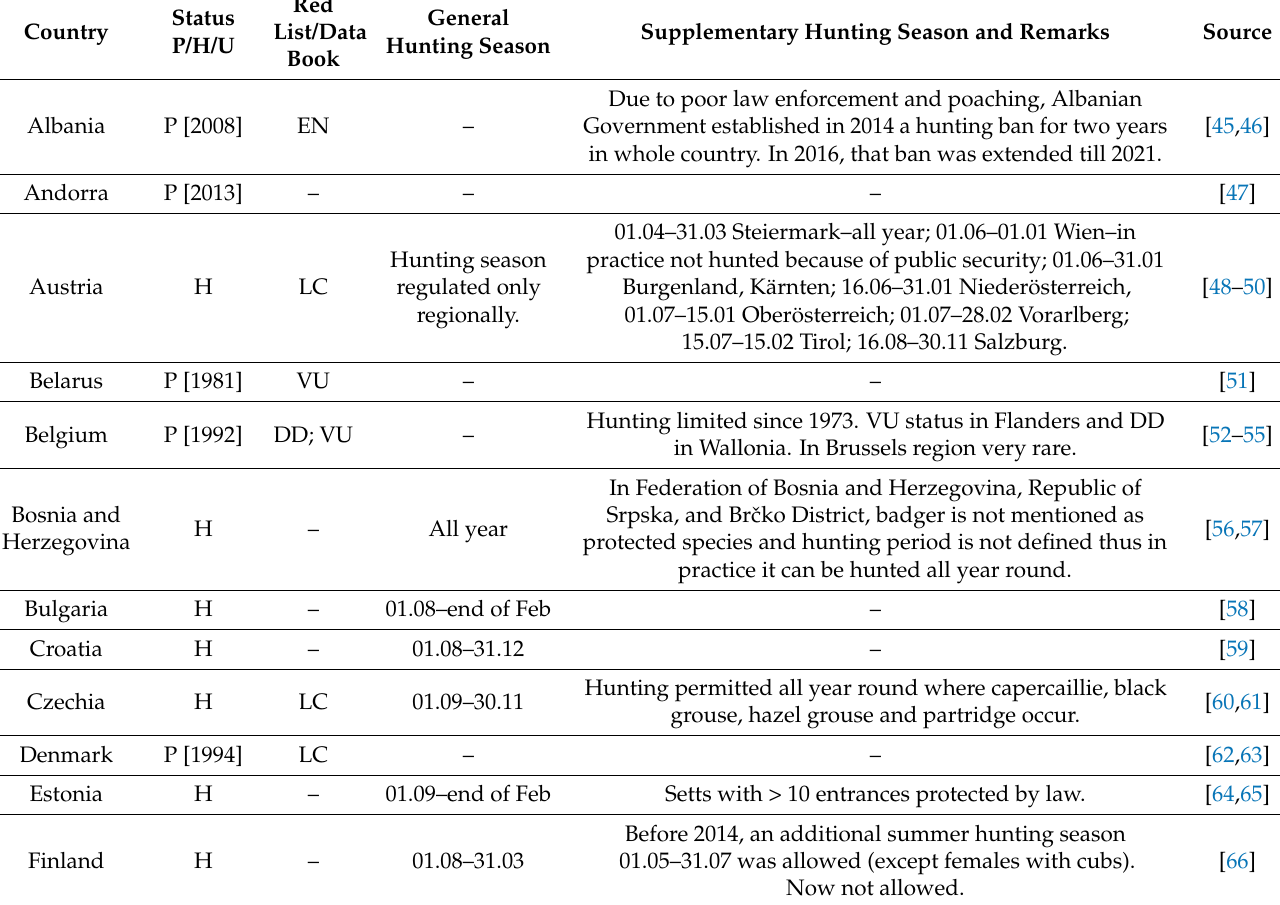
Table 1. Status of European badger Meles meles in Europe. Status: P = protected all year round; H = hunted; U = unclear: game species not hunted but also not protected. The date when the species was mentioned as fully protected is given in brackets. Updated in June